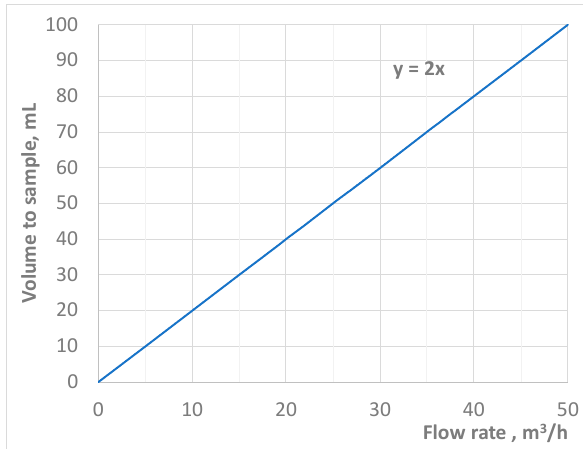
Figure 3. Relationship (direct proportionality) between volume to sample and flow rate for the flow proportional sampling mode.